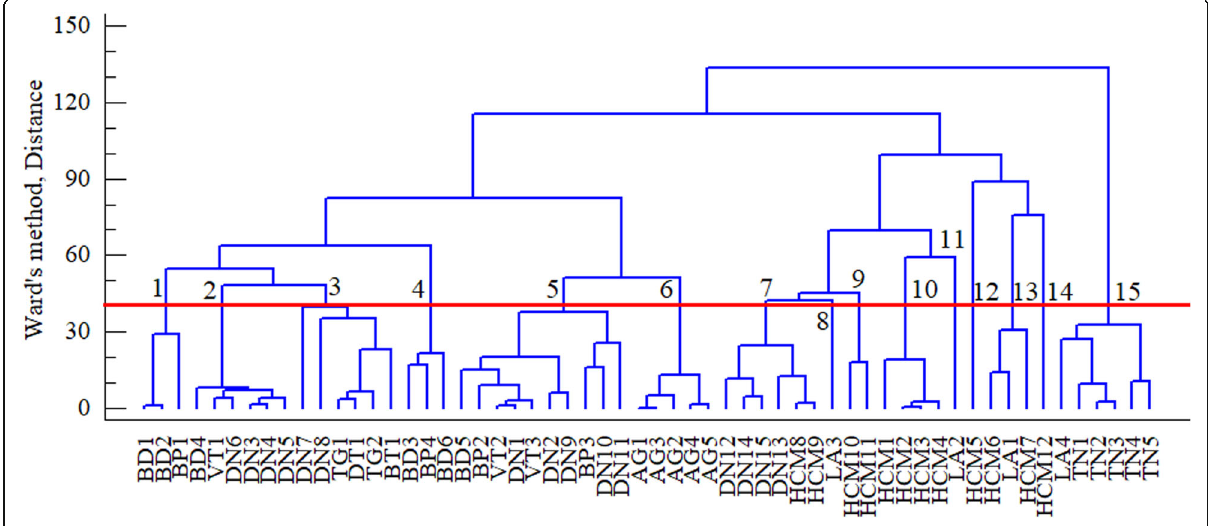
Fig. 4 Clustering surface water quality by sampling